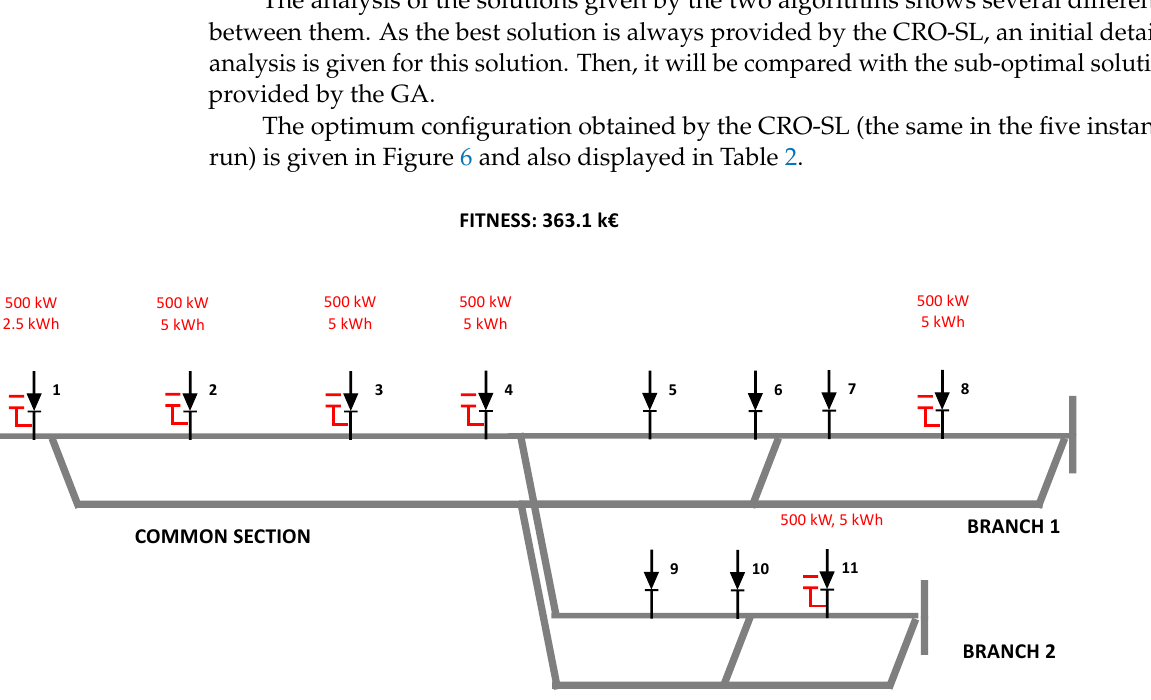
Figure 6. Optimum installation obtained by the CRO-SL algorithm for all the runs. Table 2. Best solution found by the CRO-SL. The solution is represented by a pair of columns, where the first one refers to the power size ( P [kW]) and the second to the capacity size ( C